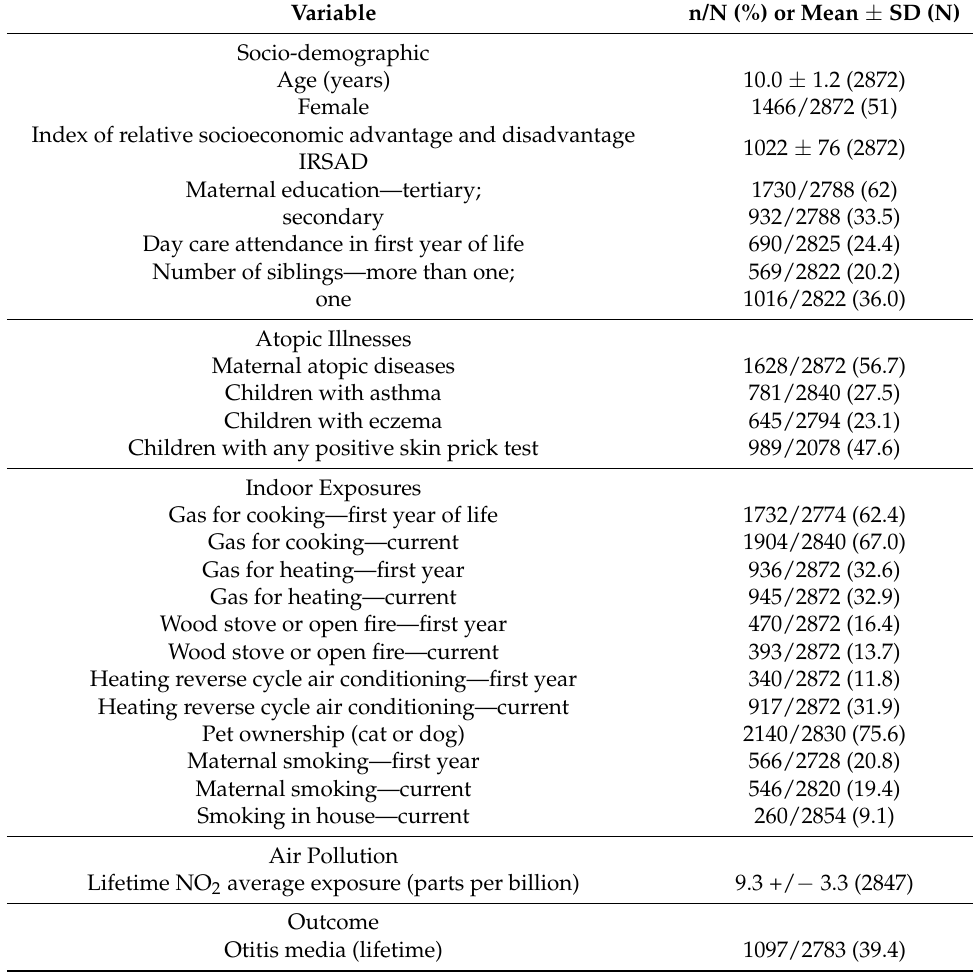
Table 1. Characteristics of the study population and the variables of